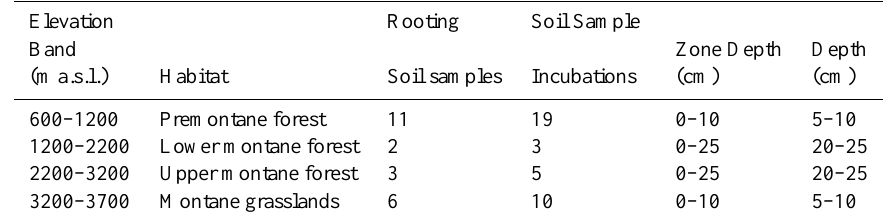
Table 2. Summary of soil sampling scheme for denitrification potential